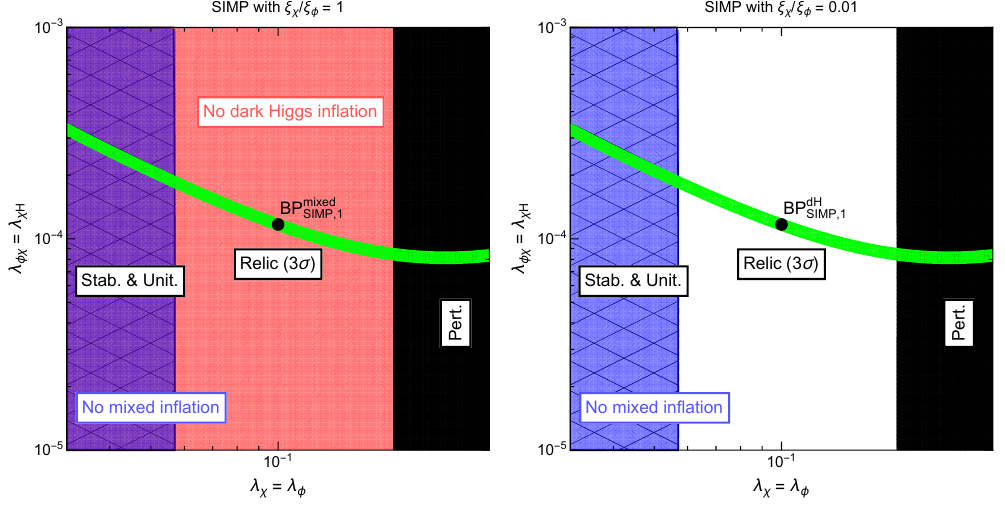
Figure 4 . Parameter space for SIMP dark matter scenario with (cid:24) (cid:31) =(cid:24) (cid:30) = 1 (left) and 0 : 01 (right), for (cid:21) (cid:30) = (cid:21) (cid:31) versus (cid:21) (cid:30)(cid:31) = (cid:21) (cid:31)H . The parameters shown here are set at low-energy scale. The rest input parameters are chosen as g X = 0 : 1, sin (cid:18) = 10 (cid:0) 6 , " = 10 (cid:0) 4 , m h 0 = 0 : 35 GeV, m (cid:31) = 0 : 1 GeV and (cid:16) = 0 : 05. The hatched and black regions are disfavored by stability, unitarity and perturbativity. The dark Higgs (mixed) in(cid:13)ation is not allowed in the red-colored (blue-colored) region. The green solid lines represent the correct dark matter relic abundance within 3 (cid:27) range [2]. The black points are our benchmark points shown in table